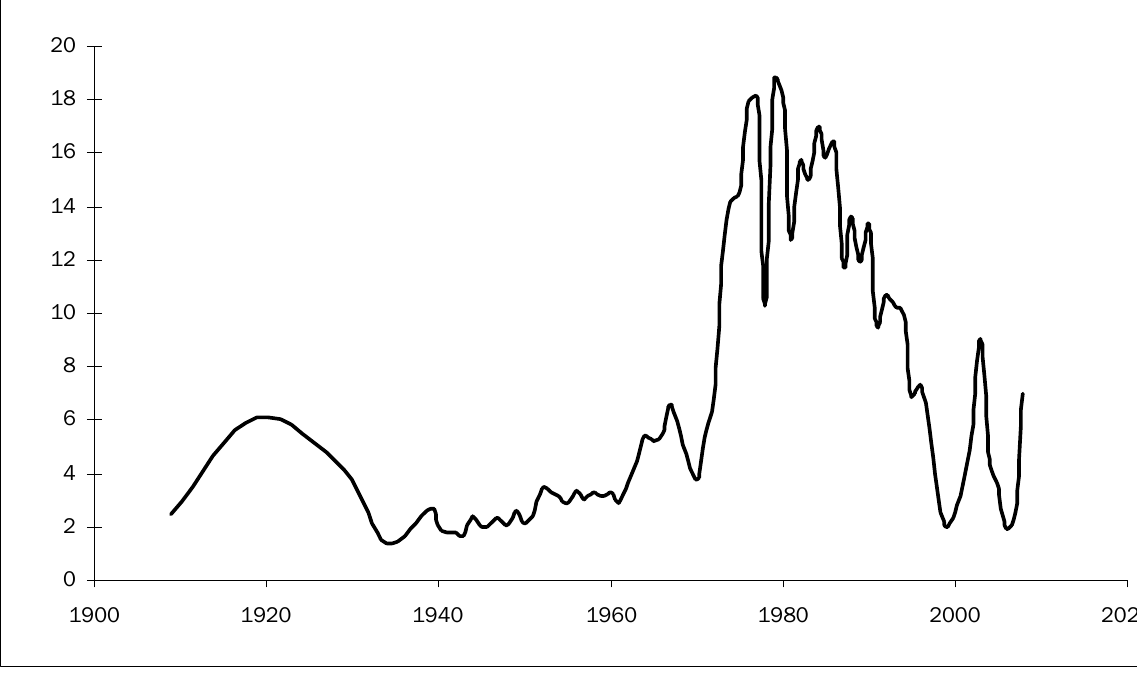
Note: The Northwest District encompasses the following counties: Benton, Clackamas, Clatsop, Columbia, Lane, Lincoln, Linn, Marion, Multnomah, Polk, Tillamook, Washinton and Yamhill. Source: USDA and NASS, 2010. Figure derived from historical survey data and annual